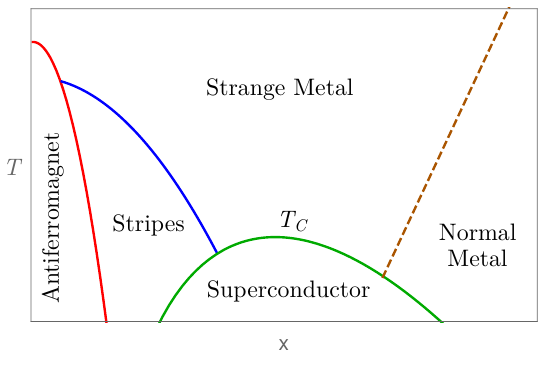
Figure 4 . Schematic phase diagram for the doped holographic superconductor